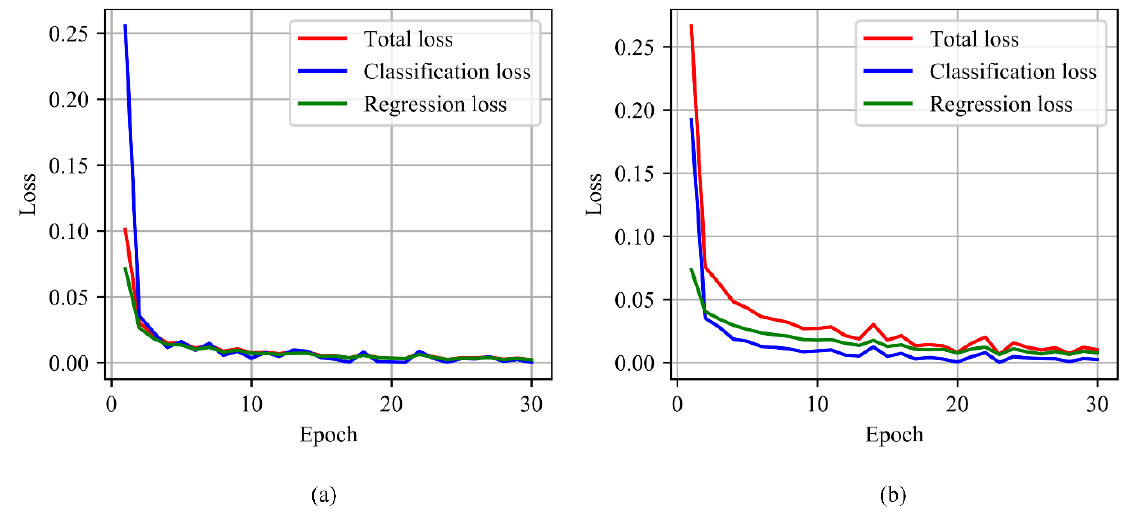
Figure 11. Comparison of loss curves between ( a ) MobileNetV2-C&R-PSO and ( b ) MobileNetV2-C&R in the training process.